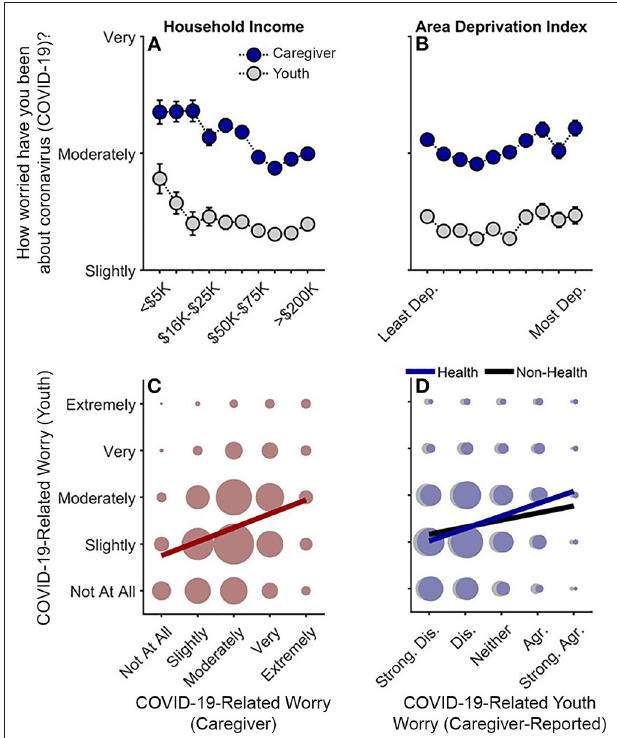
FIGURE 3 | Caregiver and youth worry levels about COVID-19. (A,B) Worry levels as functions of annual household income and area deprivation index. Error bars are ± 1 between-subjects standard error of the means. Analyses of caregiver worry controlled for caregiver education, caregiver race, caregiver ethnicity, questionnaire number, participants’ baseline study site, and participant ID. Analyses of youth worry controlled for caregiver education, child race, child ethnicity, child sex, child age, questionnaire number, participants’ baseline study site, and participant. Area deprivation index was collapsed across continuous deciles for graphing. (C) Youths’ worry levels by caregivers’ worry levels. (D) Youths’ worry levels by caregiver-reported youth worry levels about the health- and non-health-related consequences of the COVID-19 pandemic. (C,D) Circle size reflects the number of datapoints at each x-y coordinate. The solid lines are best fitting simple regression lines. Dep., Deprived; Strong. Dis., Strongly disagree; Dis., Disagree; Agr., Agree; Strong. Agr., Strongly